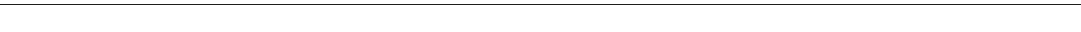
Fig. 6 TBC1D5 localizes to LCVs and promotes growth of L. pneumophila . a Imaging fl ow cytometry (IFC) images of LCVs from homogenized D. discoideum DH1 producing in tandem GFP-TBC1D5 (pFL1304) and AmtA-mCherry as an LCV marker, infected (MOI 50, 2 h) with mPlum-producing L. pneumophila JR32 or Δ icmT (pAW14). b Quanti fi cation by IFC of the intensity of GFP-TBC1D5 on > 3000 LCVs per sample at the time points post-infection indicated. The data show mean and 95% con fi dence intervals of one representative experiment out of three independent biological replicates (*** P < 0.001; two-way ANOVA with Bonferroni post hoc test). c D. discoideum DH1 stably producing GFP-TBC1D5 was infected (MOI 20, 2 h) with DsRed-producing